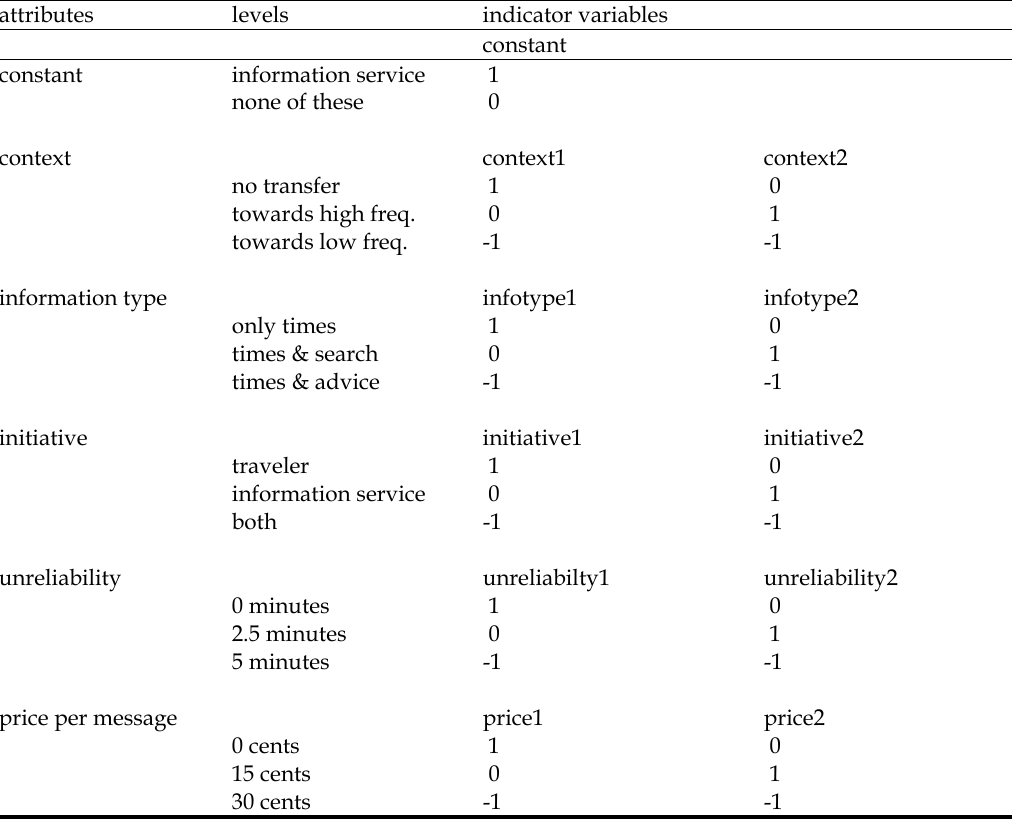
Table 3 . Applied coding